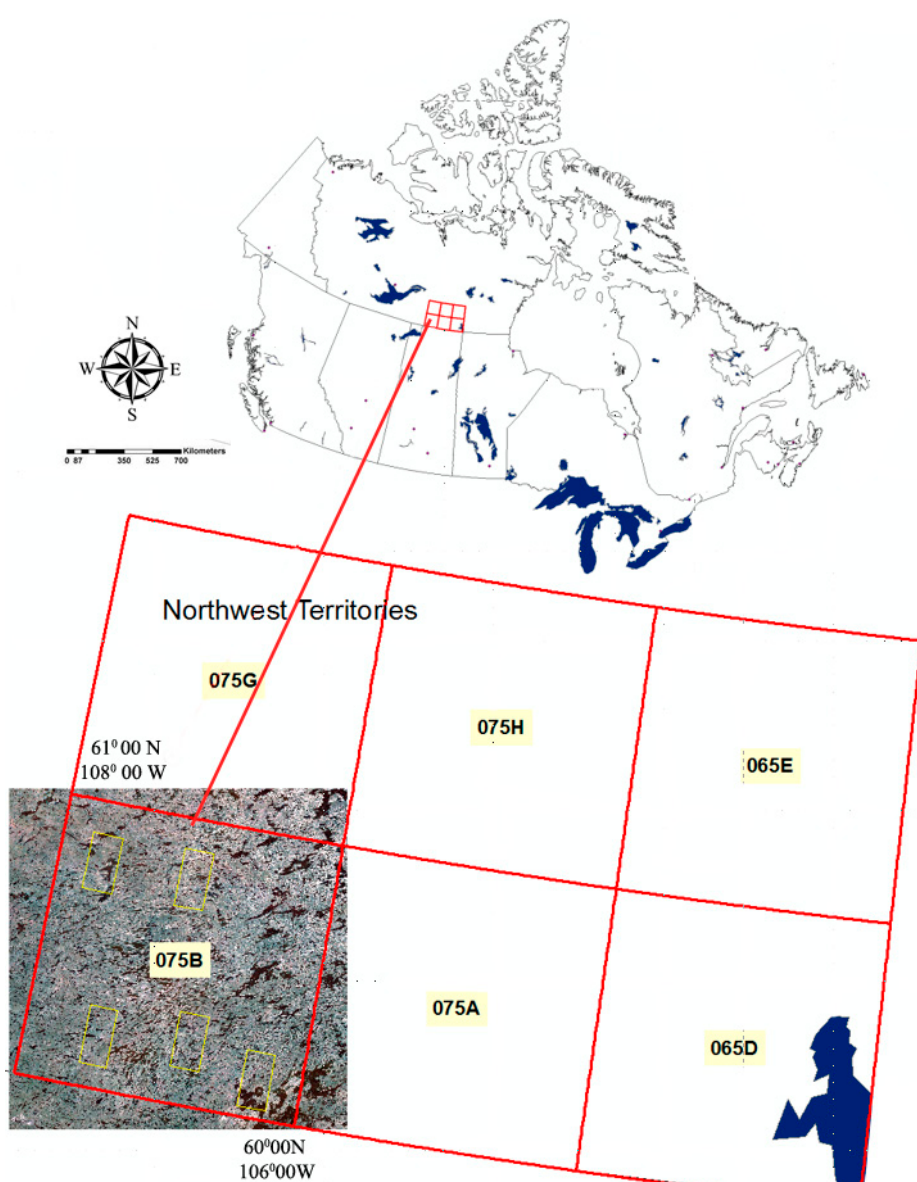
Figure 1. Location of the study area.